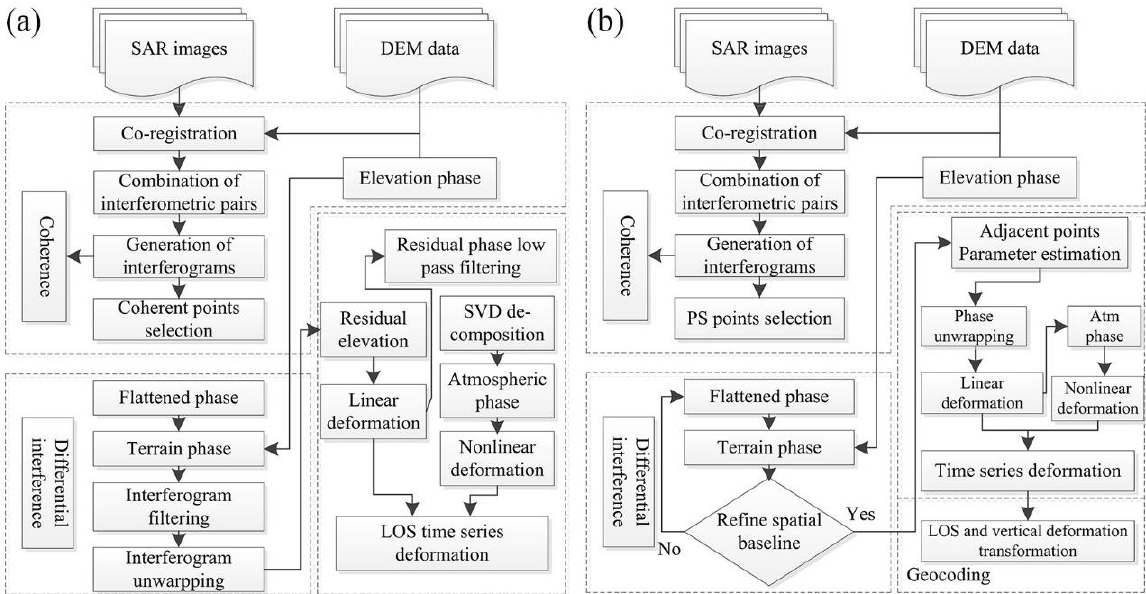
Figure 4. Workflow of ( a ) SBAS-InSAR and ( b ) PS-InSAR.